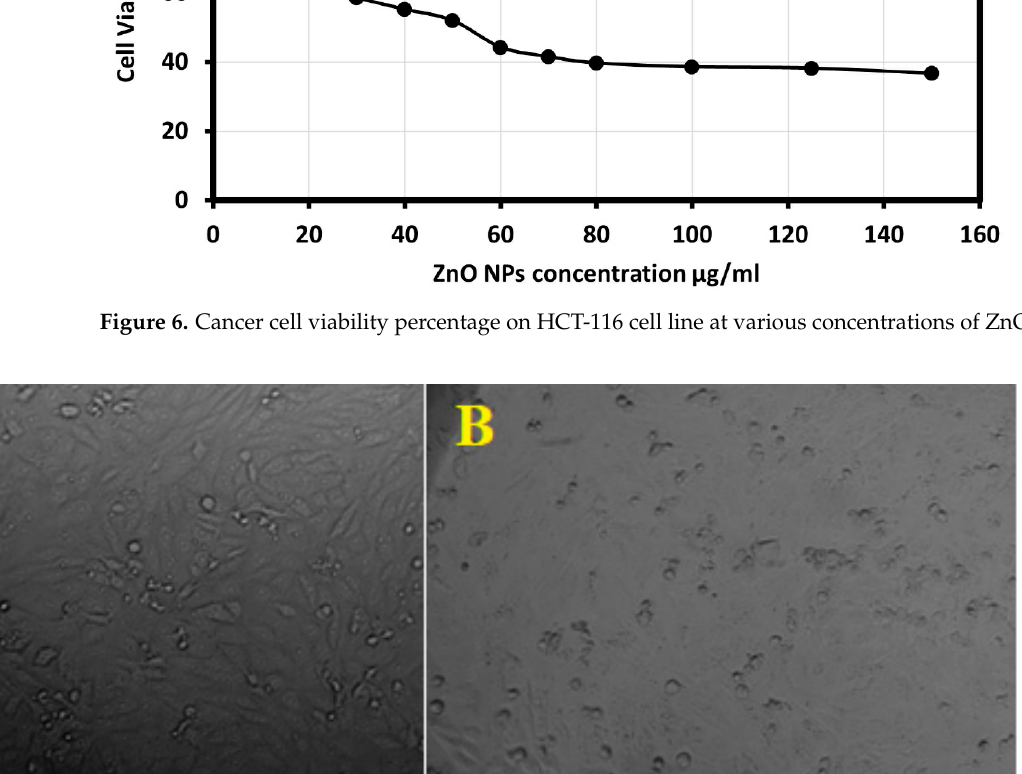
Figure 7. Morphological changes of HCT- 116 cell line due to the cytotoxicity effect of ZnO NPs. (( A ). Control. ( B ). Morphological changes in the cell after 24 h. scale bars = 200 μ m).